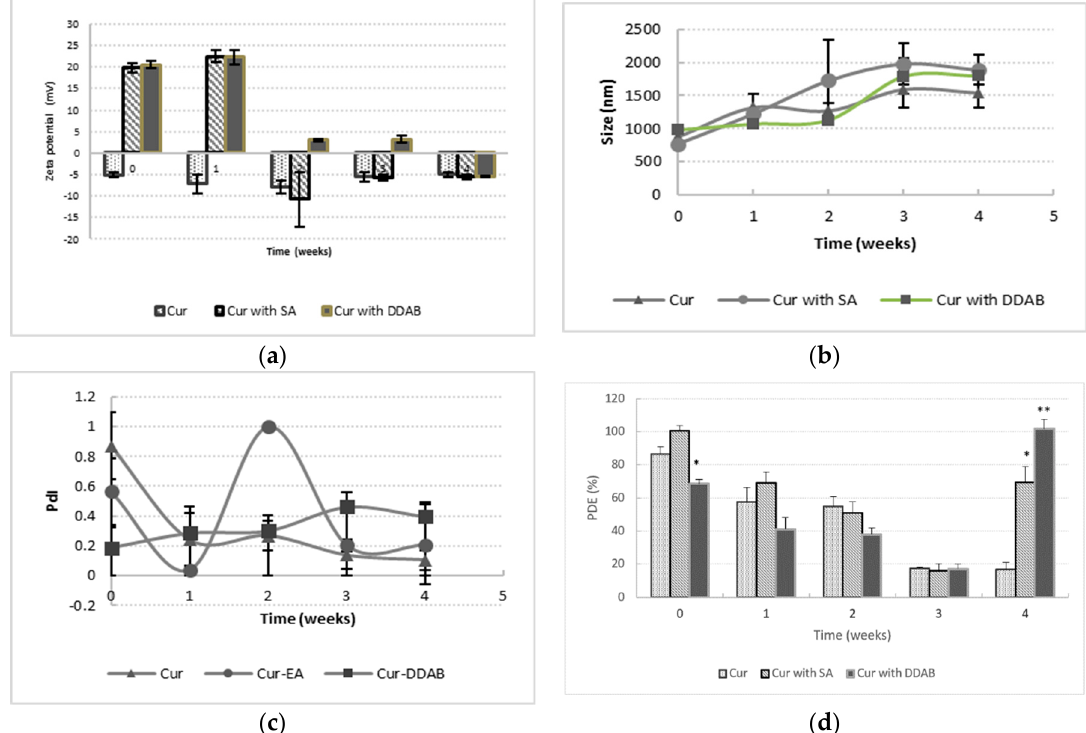
Figure 3. Physicochemical properties: zeta-potential ( a ), mean diameter ( b ), polydispersity index ( c ), and percentage of Cur entrapment ( d ). For each formulation, at least three different samples were prepared; values presented are mean values ± SD and were significantly different compared with the Cur group (* p < 0.05, ** p < 0.01; Student t test).